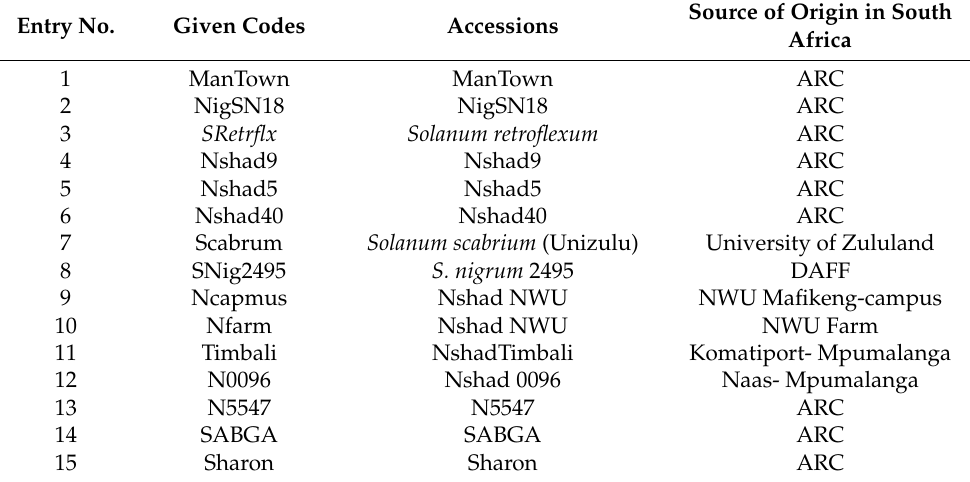
Table 5. Fifteen nightshade accessions evaluated during the